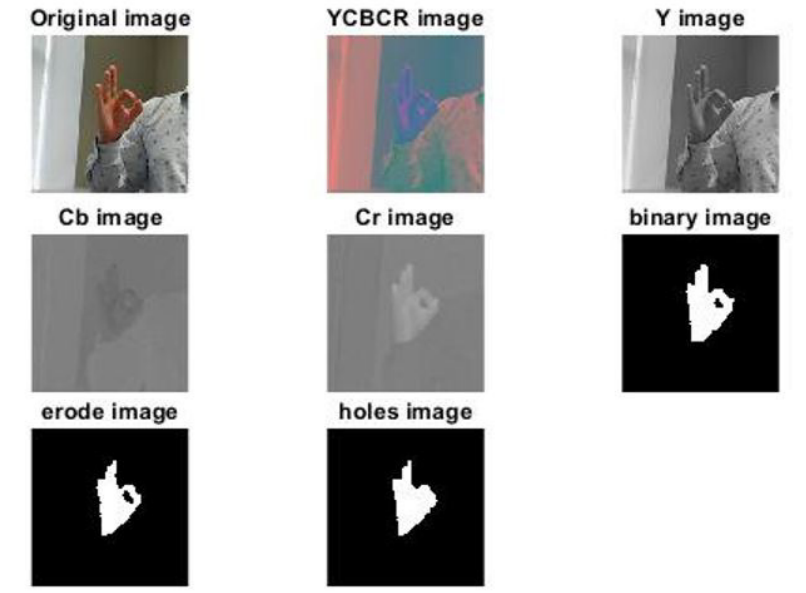
Figure 3. YCbCr segmentation process of an input